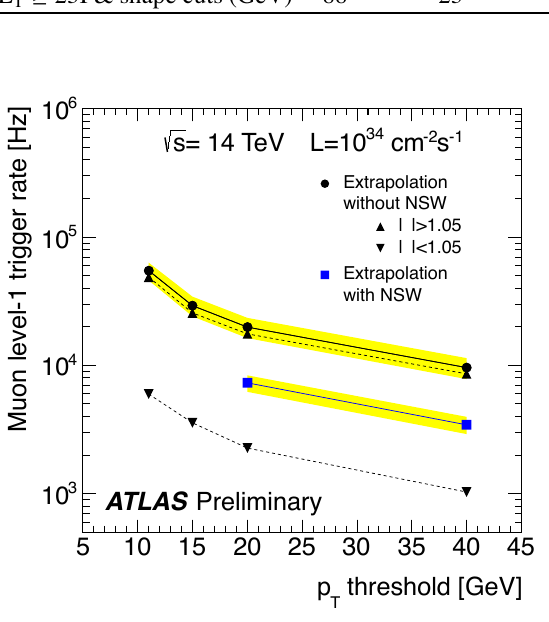
Figure 3. Level-1 muon trigger rate as a function of muon mo- mentum at a luminosity of 10 34 cm − 2 s − 1 . The solid line shows the total muon rates with and without the new small wheel. The dotted lines show the currently observed rates in the central and forward